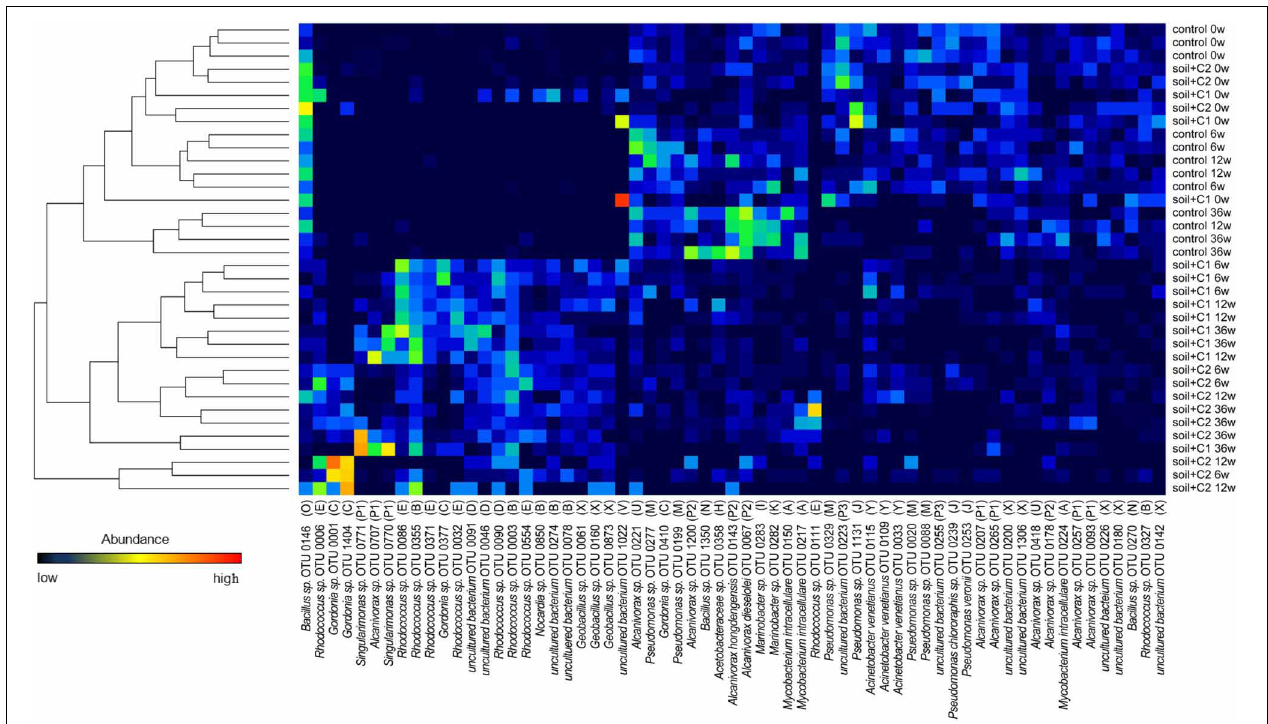
FIGURE 5 | Heat map of OTUs (containing > 50 sequences) that were counted for each sample. Similarity of the bacterial community for each sample was calculated based on the abundance of each OTU and